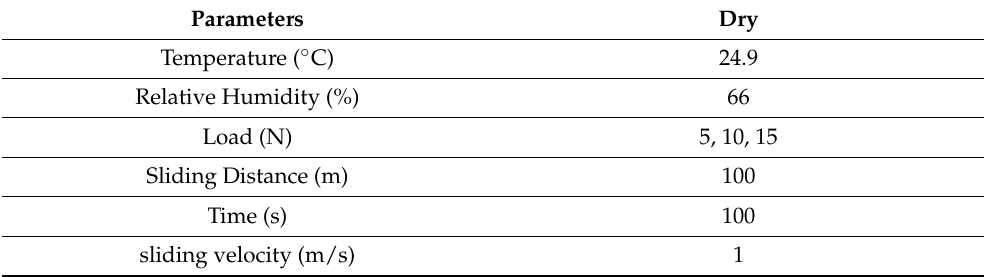
Table 5. Experimental